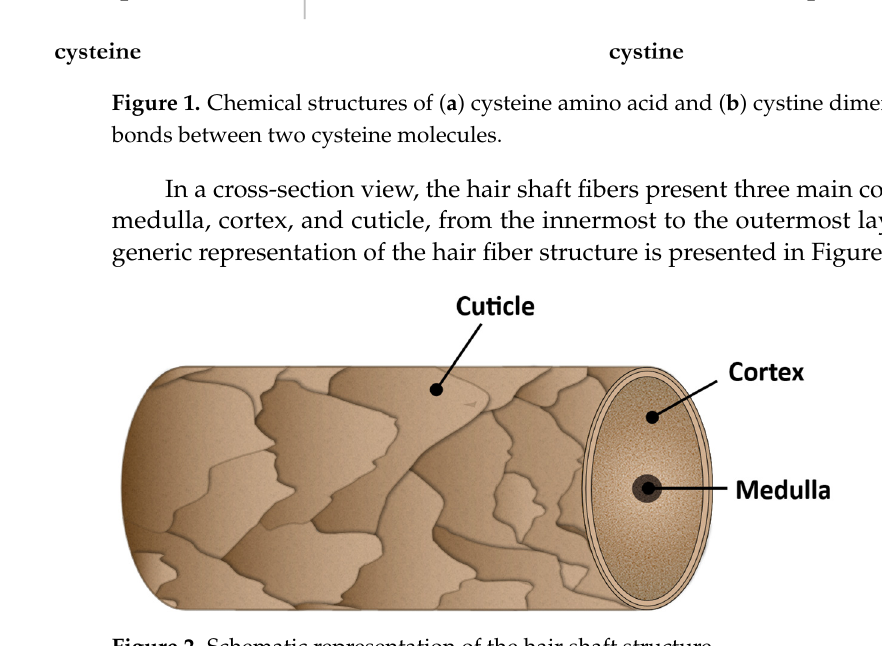
Figure 2. Schematic representation of the hair shaft structure.